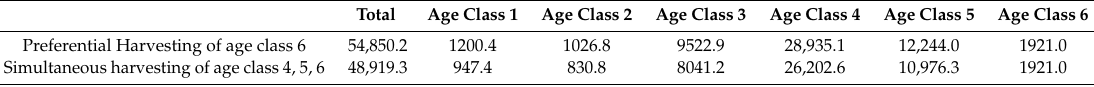
Table 6. Estimated value of forested area by age class, by harvesting decision.